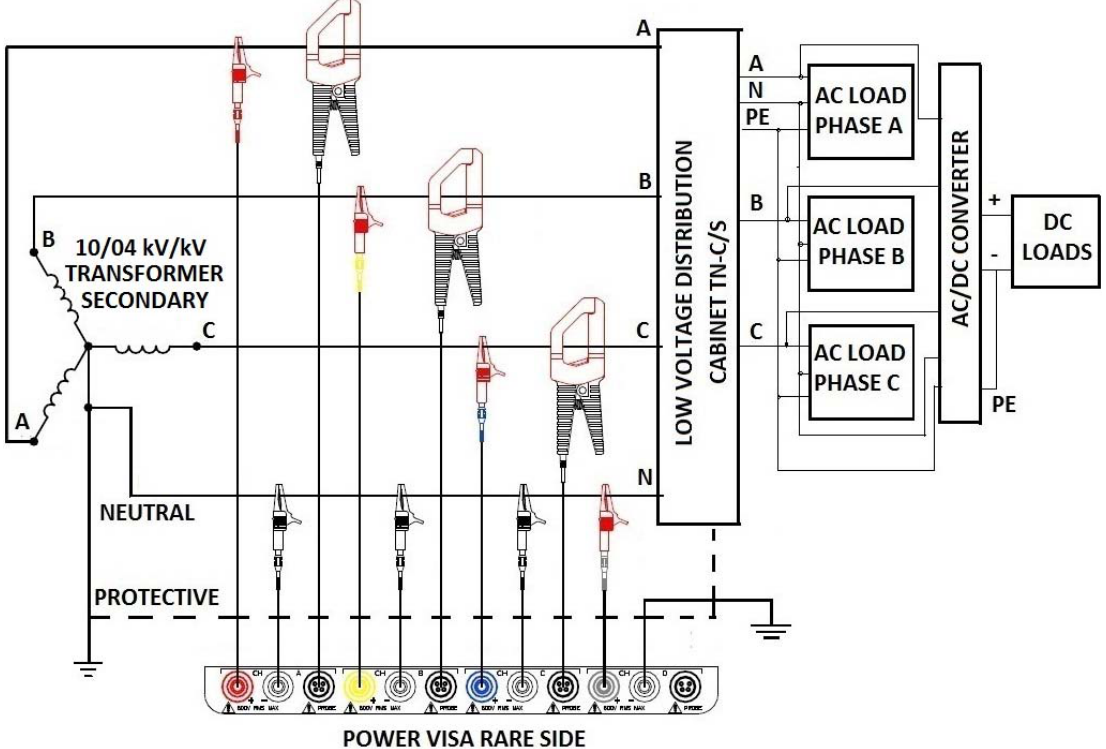
Figure 3. Contacting scheme for measuring AC consumption of compleate BSs